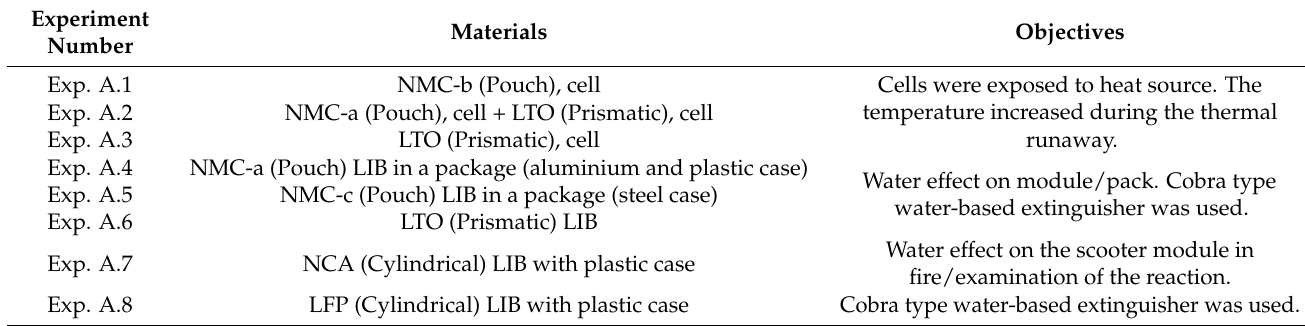
Figure 11. Propane gas burner (400 kW). Table 2. Exp. A experimental